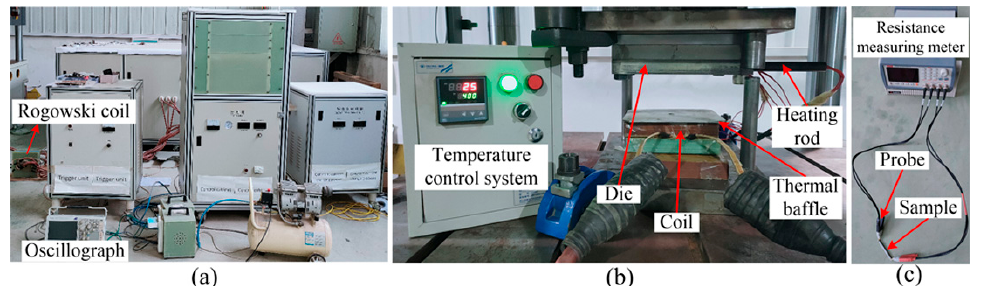
Figure 1. Experimental apparatus: ( a ) electromagnetic forming machine; ( b ) forming apparatus; ( c ) resistance measuring instruments.